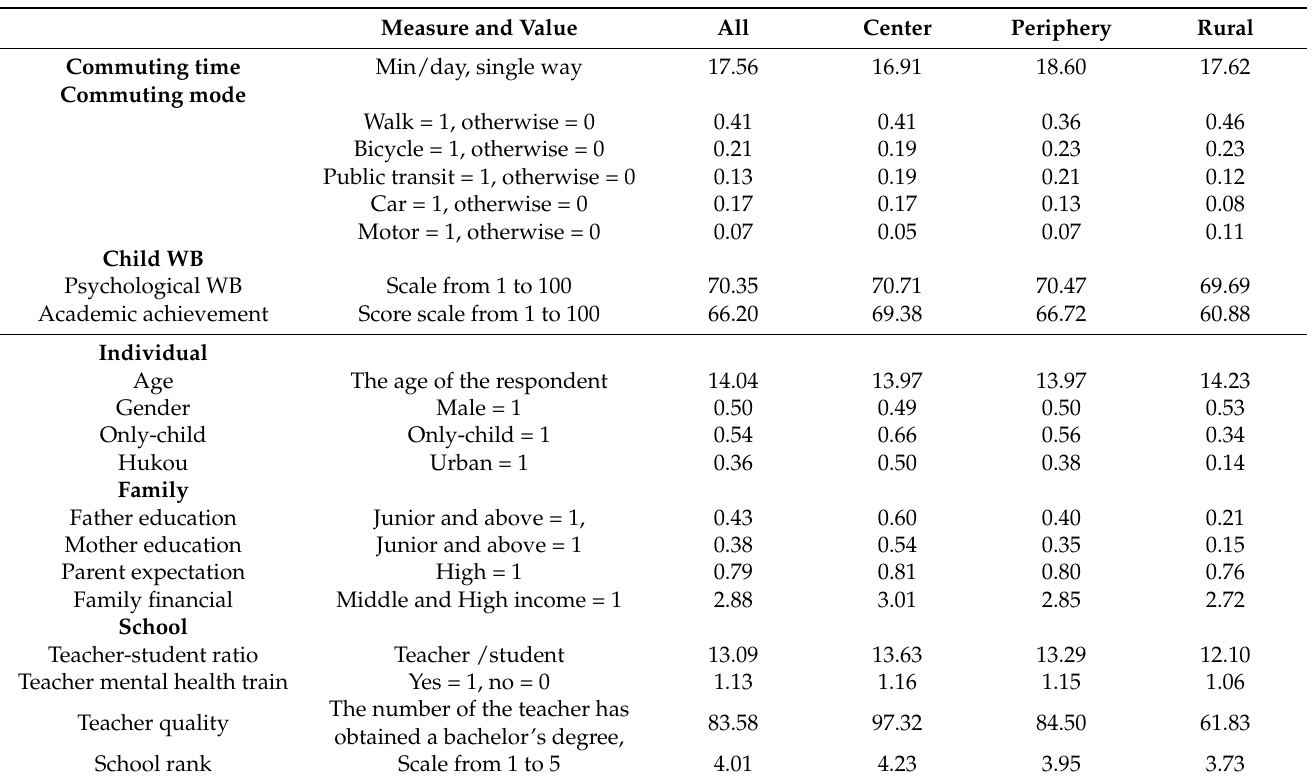
Table 1. Variable definitions and descriptive statistics.